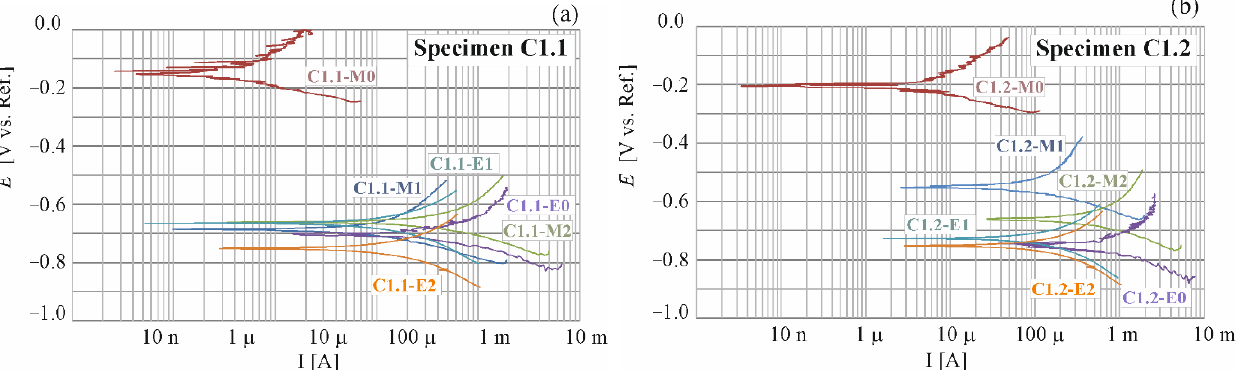
Figure 4. Potentiodynamic polarization curves for steel reinforcement in concrete C1 obtained for